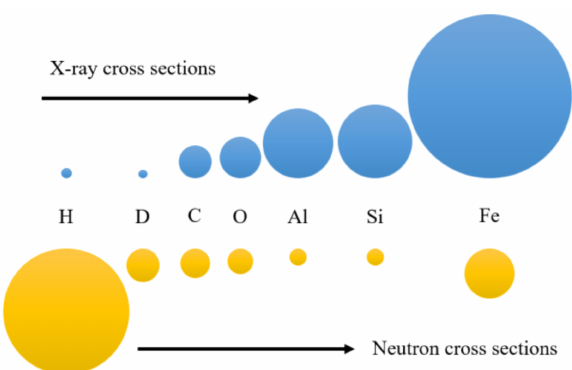
Figure 1. Trend of X-ray and neutron cross-section from lighter to heavier atoms